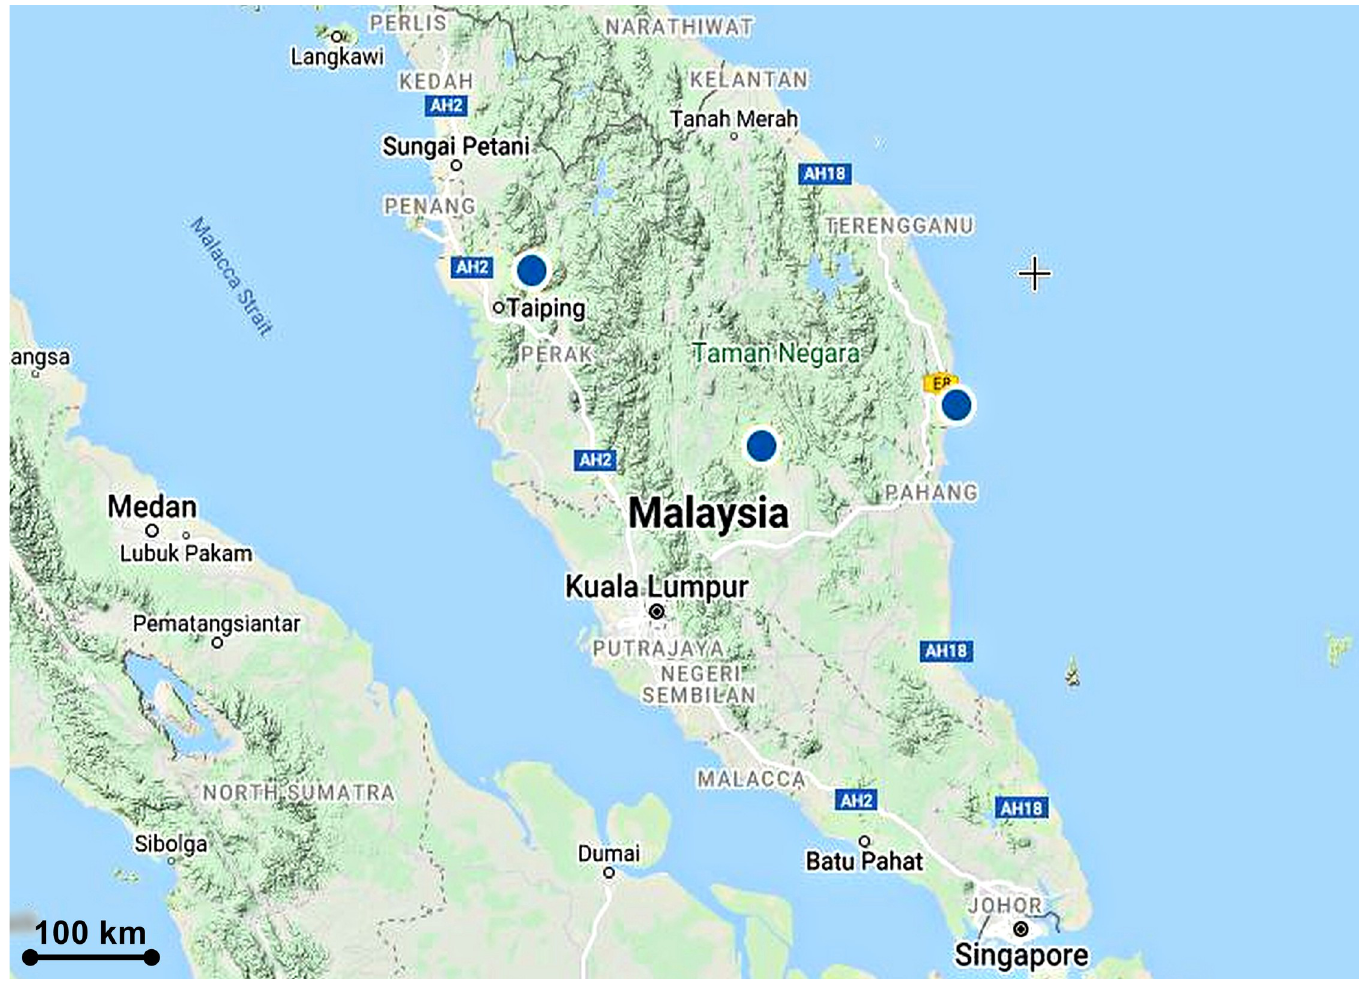
Fig 14. Distribution of Taeniophyllum rugulosum